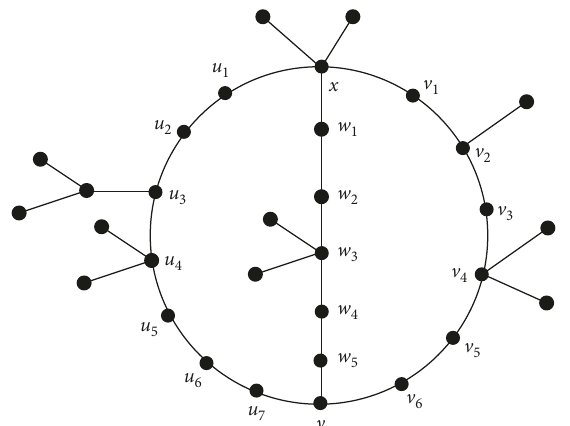
Figure 6: Graph G for Example